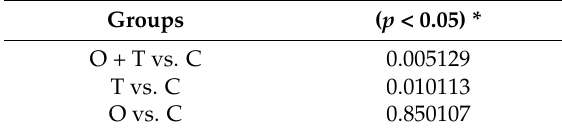
Figure 4. ( A ) Histogram indicating markers of precursor B cells/Pro-B cells in each studied group. These cells are characterized by appearances of CD24 +, CD90 +++, CD45 ++, and CD34 ++; and ( B ) Graph of the percent of precursor B/Pro-B cells in each group and the result of the Kruskal- Wallis statistical test, p value = 0.001.